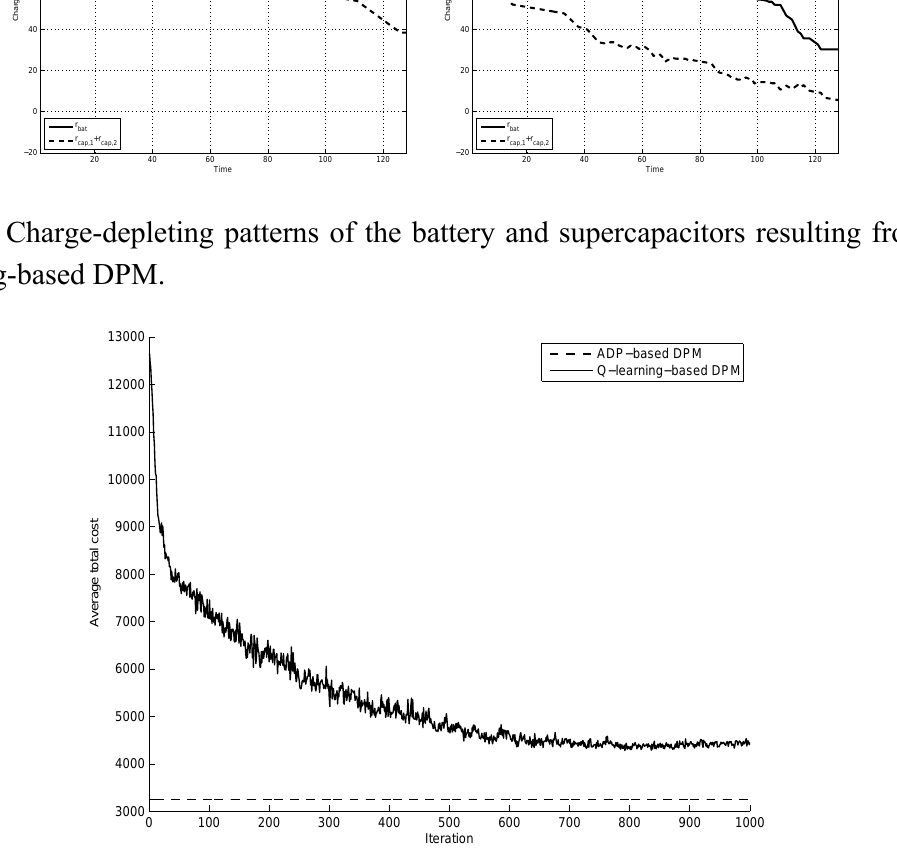
Figure 5. Learning curve (the average total cost vs. the iteration over a set of 10 simulation runs): Q-learning (dashed) and ADP